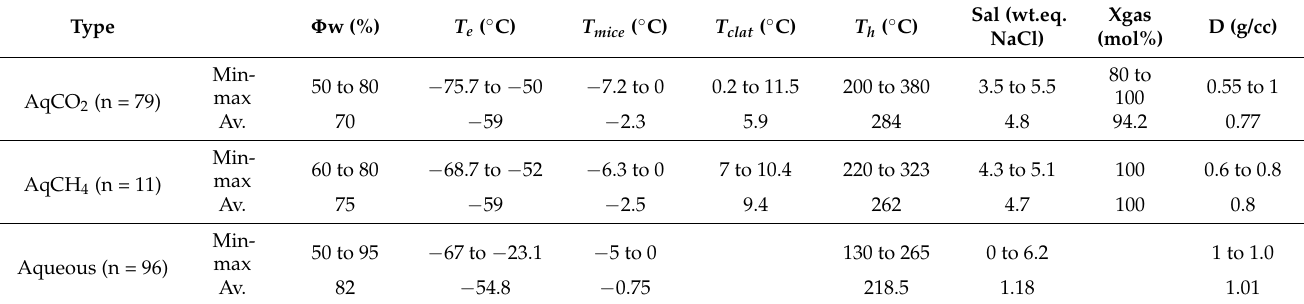
Table 4. Microthermometric data for aqueous-carbonic fluid. AqCO 2 —aqueous CO 2 FI; AqCH 4 —